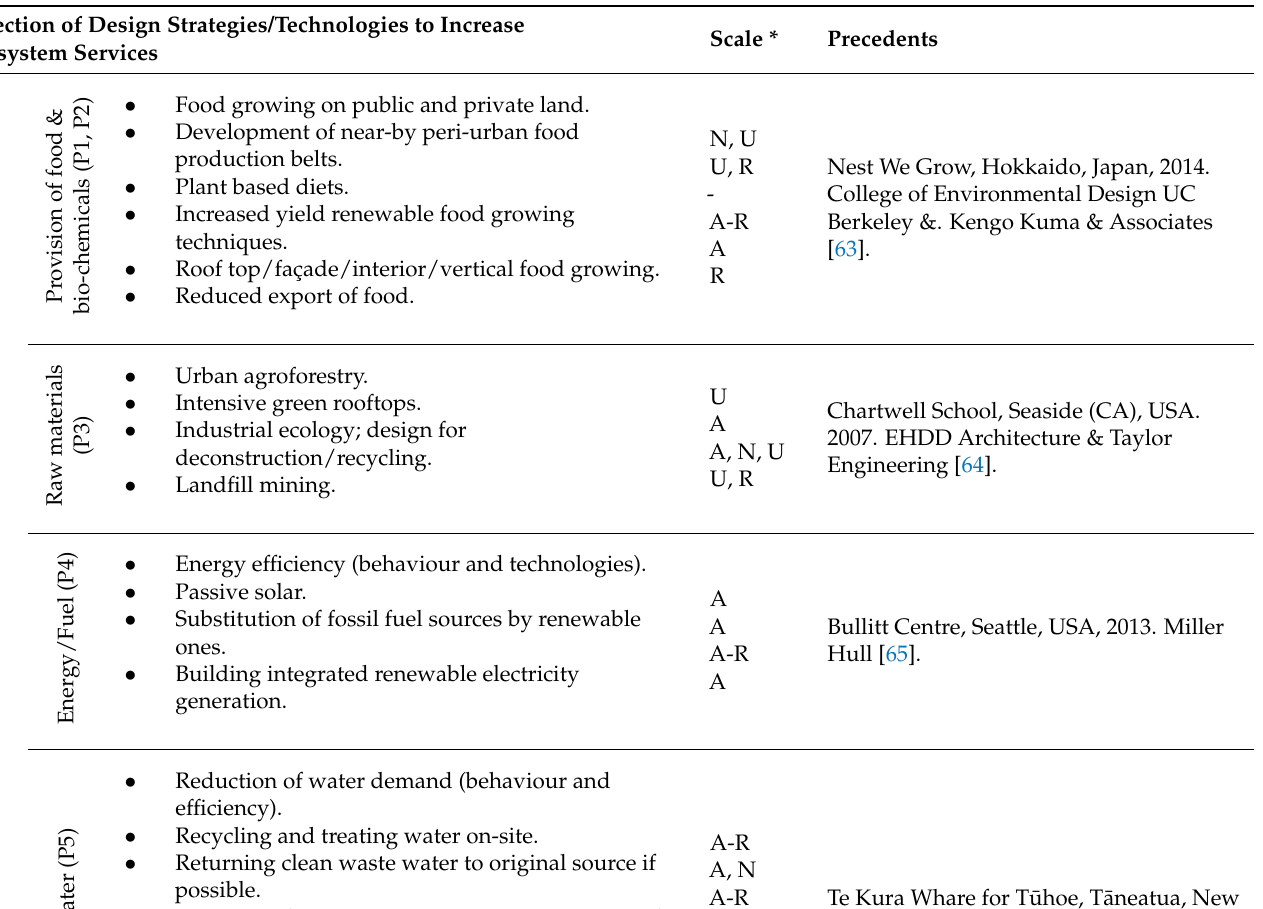
Table 2. Provision of urban ecosystem services with precedents. Selection of Design Strategies/Technologies to Increase Ecosystem